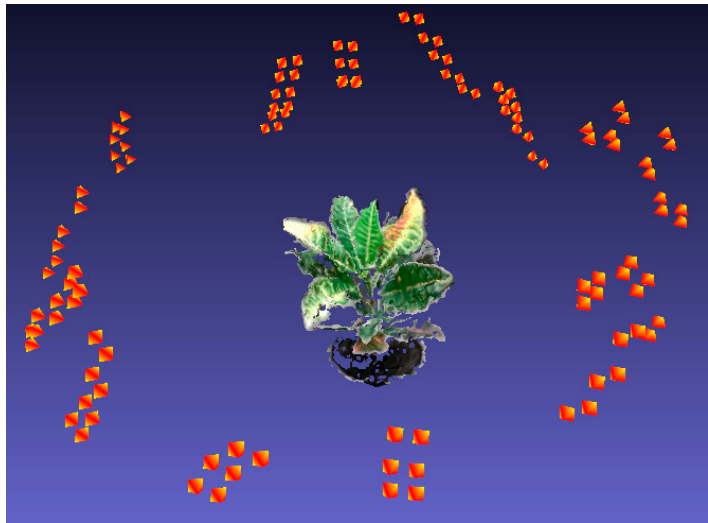
Figure 5. An example of stereo camera setup for image acquisition with the 3D reconstruction results (56 stereo pairs were